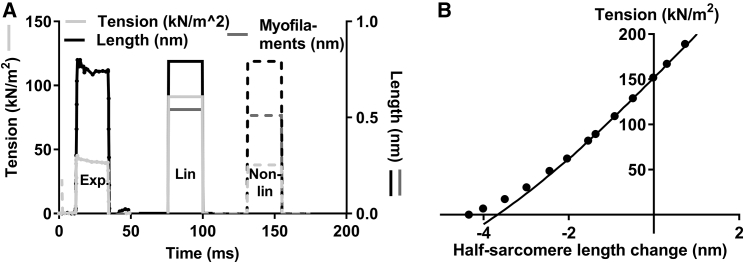
Tension responses to half-sarcomere length changes imposed on a muscle fiber in rigor. A comparison of model responses to experimental data from a skinned rabbit psoas muscle fiber at sarcomere length (2.37 μm) with maximal overlap between thin and thick filaments (39) is shown. (A) Tension change (light gray; left vertical axis) in response to total half-sarcomere-length changes (black; right vertical axis). Experimental data (filled circles and lines; “Exp”), simulated data assuming linear cross-bridge elasticity (filled straight lines; “Lin”) or simulated data assuming nonlinear cross-bridge elasticity (dashed lines; “Non-lin”) are shown. The cross-bridge force-extension relation for nonlinear case is taken from red line in Fig. S1A. The length change attributed to series elastic element in myofilaments (dark gray; right axis) is also indicated in model simulations. (B) The relationship between force and half-sarcomere length (“T1 curve”) in experiments (full circles) and model simulations (line) assuming nonlinear cross-bridge elasticity. The experimental data were obtained by measurements from Fig. 9 a in (39)). In the model simulations, ∼1/3 of the total sarcomere compliance was attributed to the cross-bridges, whereas ∼2/3 was attributed to the myofilaments in series (39).